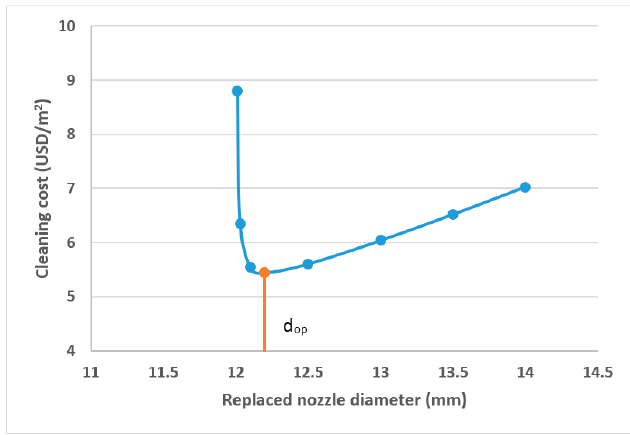
Figure 5. Cleaning cost versus replaced nozzle diameter.